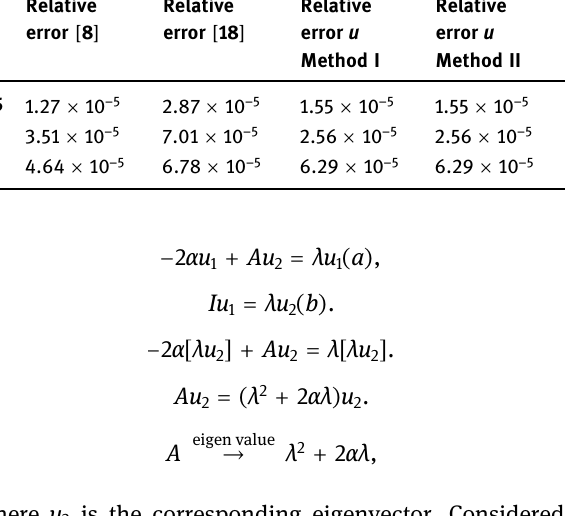
Table 19: Comparison of errors for = α 10 , = β 5 , = N 21 , = t Δ 0.0001 , and = τ 0.5 regarding Example 7 [ 8 ]